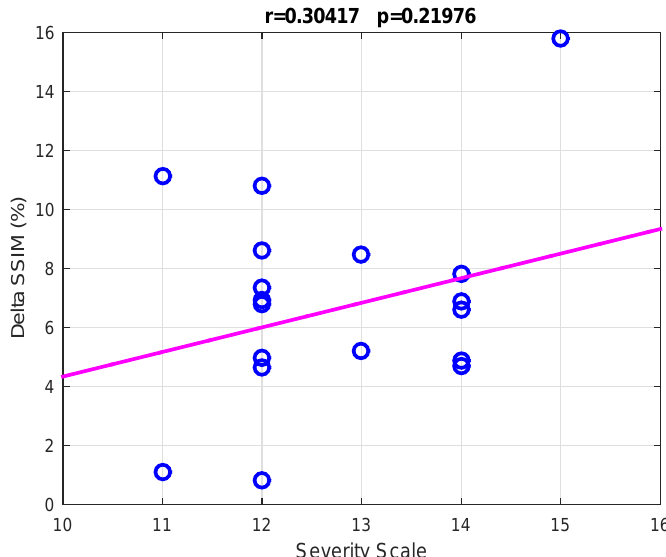
Figure 6. Analysis of the correlation between the severity scale and differences in the compressibility of the EEG signals of the two hemispheres. The correlation between ∆ SSIM and the severity scale was assessed by the Pearson’s linear correlation test. Each blue circle represents the severity scale vs. ∆ SSIM of a given subject. Since p = 0.21976, no significant correlation between ∆ SSIM and the severity scale could be